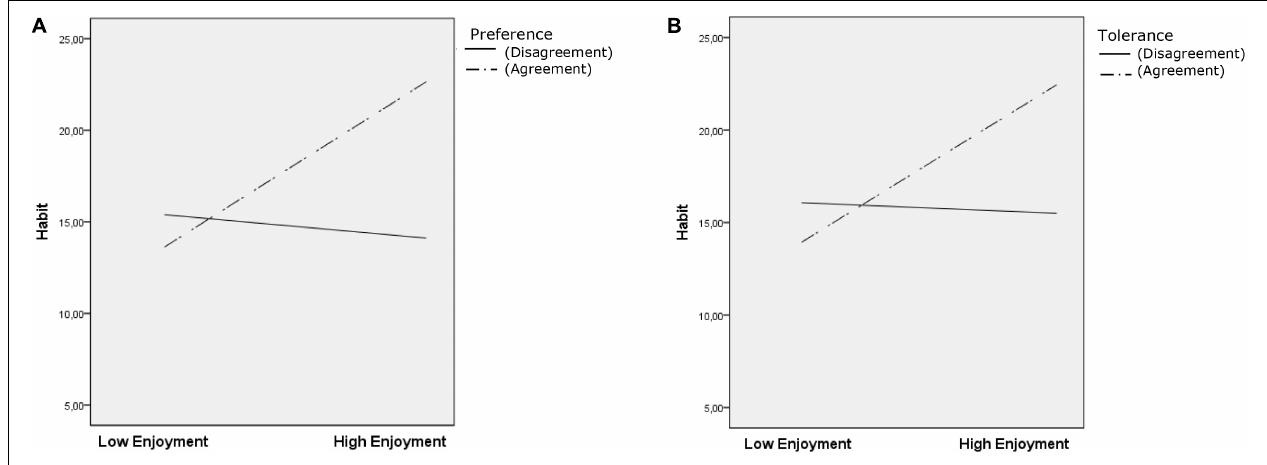
FIGURE 1 | Conditional effects analysis for the preference and tolerance levels of agreement/disagreement on exercise habit.